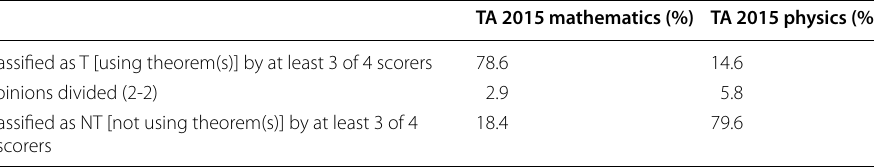
Table 5 Classification of TIMSS Advanced items using the T/NT dichotomy, in percentages of